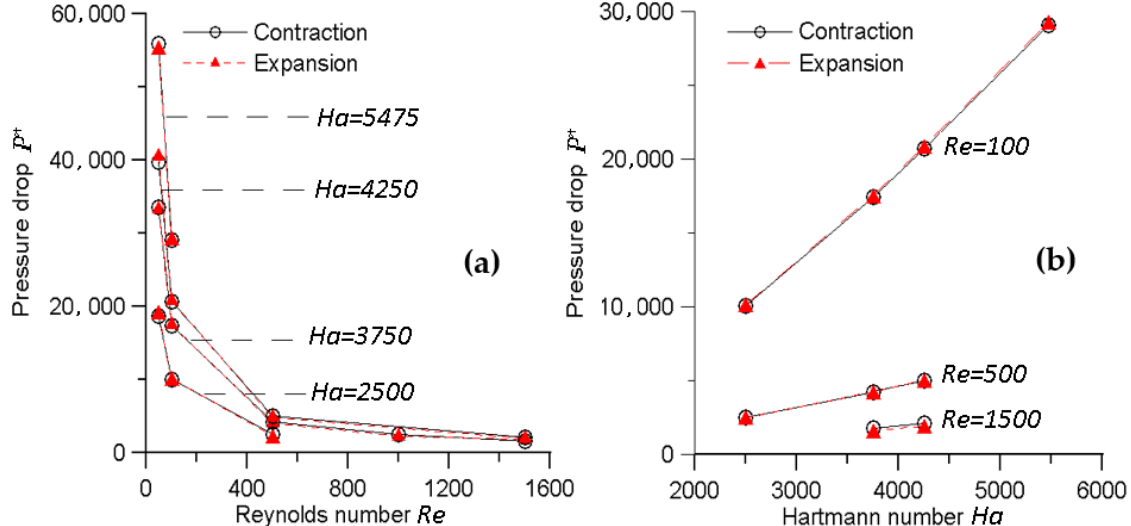
Figure 20. Dimensionless 3D MHD pressure drop P * scaled by the dynamic head in a LM duct flow with sudden expansion or contraction. ( a ) Effect of the Reynolds number. ( b ) Effect of the Hartmann number.